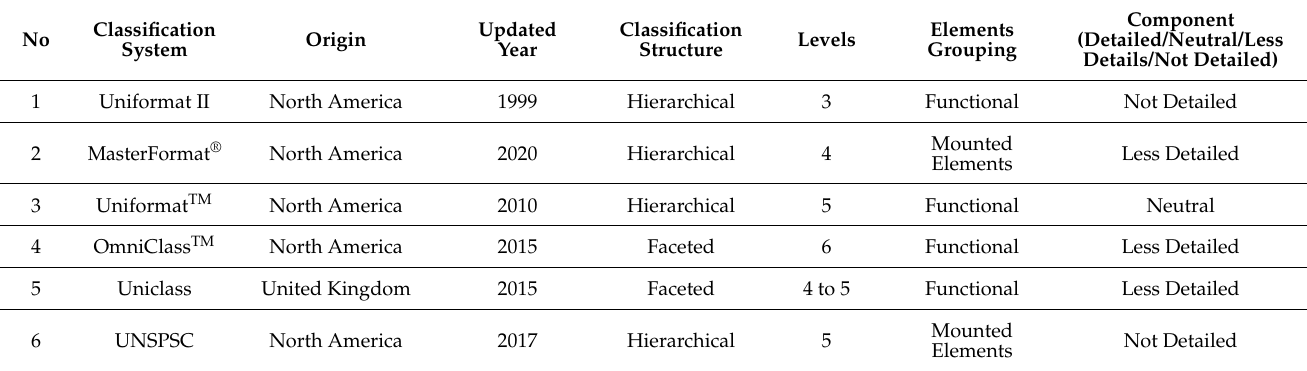
Table 1. Comparison of the current classification systems